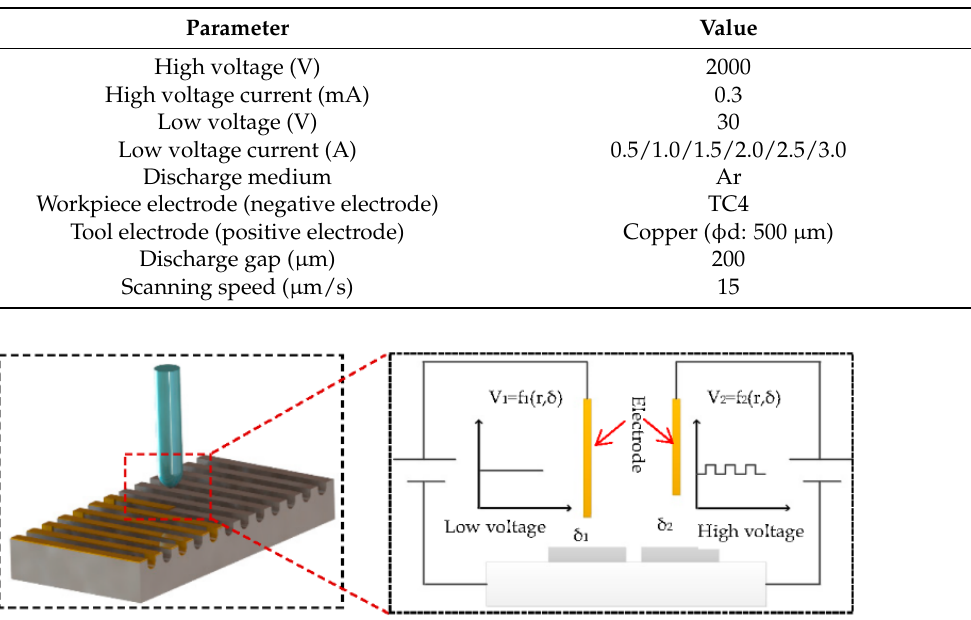
Figure 2. Schematic diagram of high voltage-induced weak arc for microstructure.